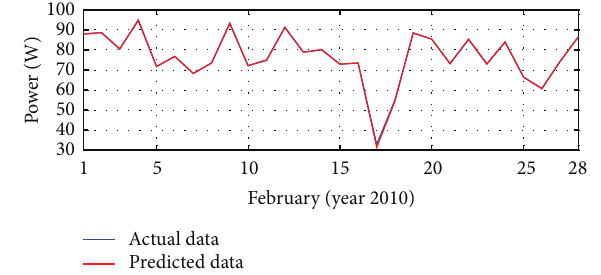
Figure 6: Results for real data and FFBP for February 2010.